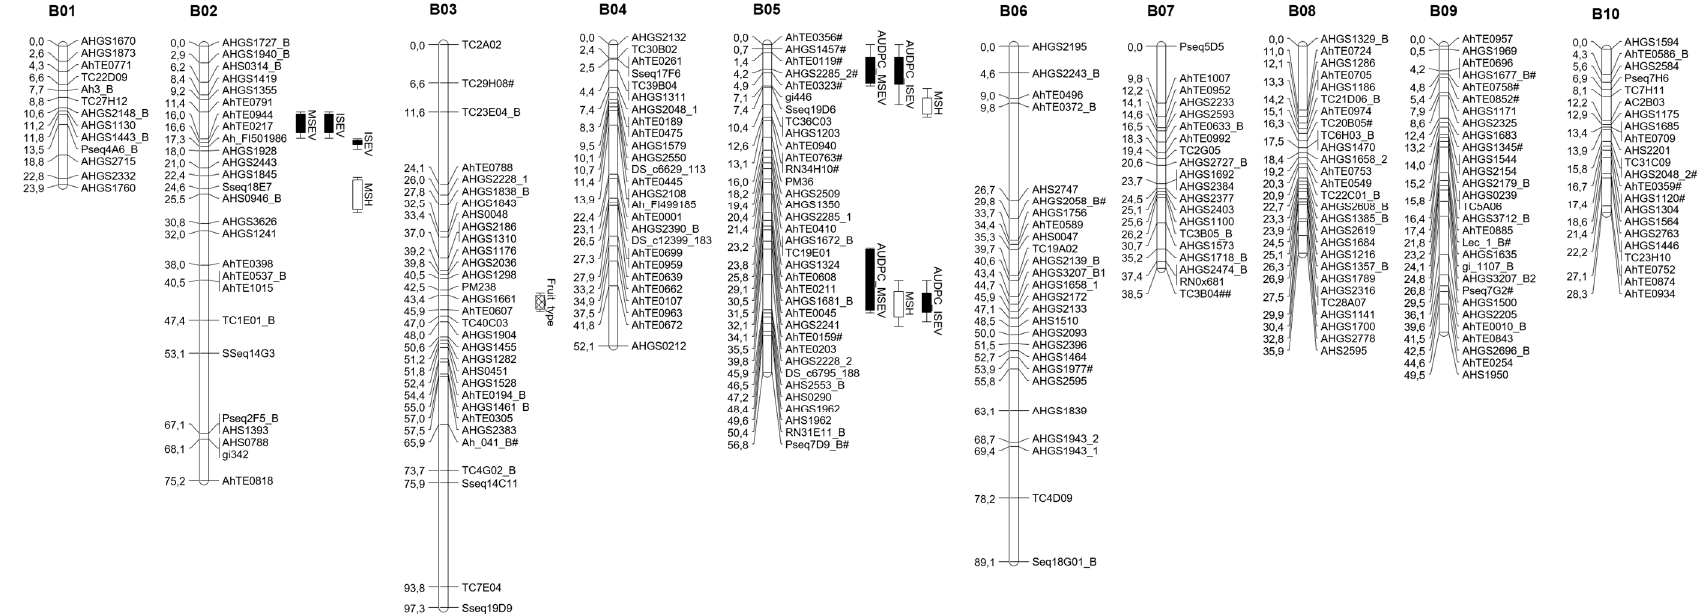
Figure 4. A genetic linkage map obtained through the analysis of 87 F 6 plants, generated from a cross between A. hypogaea ‘Runner IAC 886’ and the induced allotetraploid ( A. ipaënsis K 30076 x A. duranensis V 14167) 4x . Numbers on the left of each group are Kosambi map distances (cM). Markers that amplified more than one locus have numbers _1 and _2 after the marker name. Quantitative Trait Loci are indicated as bars running alongside linkage groups. Color/textures are according to categories: black, LLS resistance; white, plant architecture; textured, fruit type. Distorted alleles ( p < 0.05) are indicated by ‘#’.